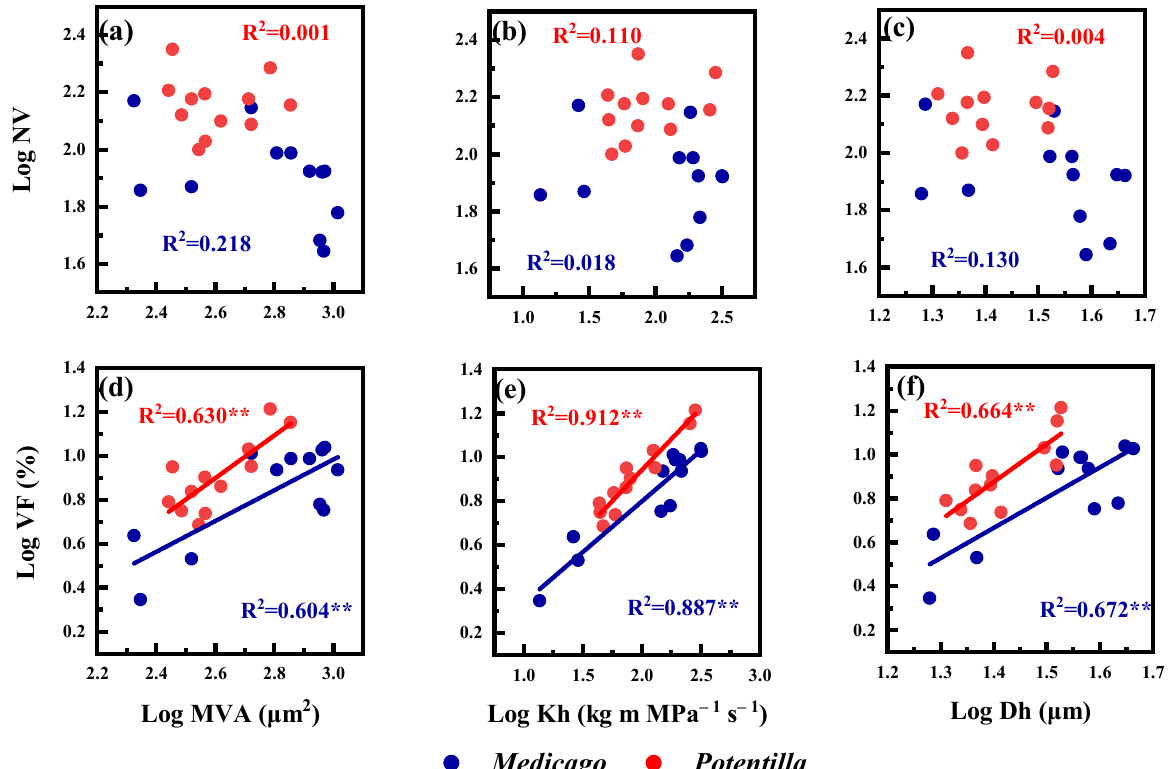
Figure 5. Correlation relationships between NV, VF and major hydraulic traits in secondary root xylem of non-native and native forbs in arid and semiarid areas. ( a – c ) Relationships between vessel number and hydraulic traits; ( d – f ) Relationships between vessel fraction and hydraulic traits. NV—vessel number; VF—vessel fraction; MVA—mean vessel area; Kh—the potential hydraulic conductivity; Dh—hydraulic diameter. The blue and red dots indicate Medicago and Potentilla herbaceous species, respectively. ** p < 0.01.